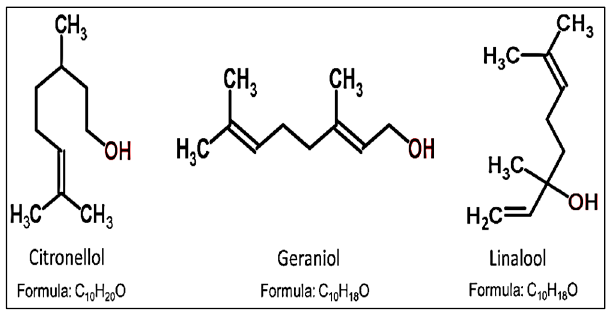
Figure 1. The chemical structure of main components of pelargonium essential oil.